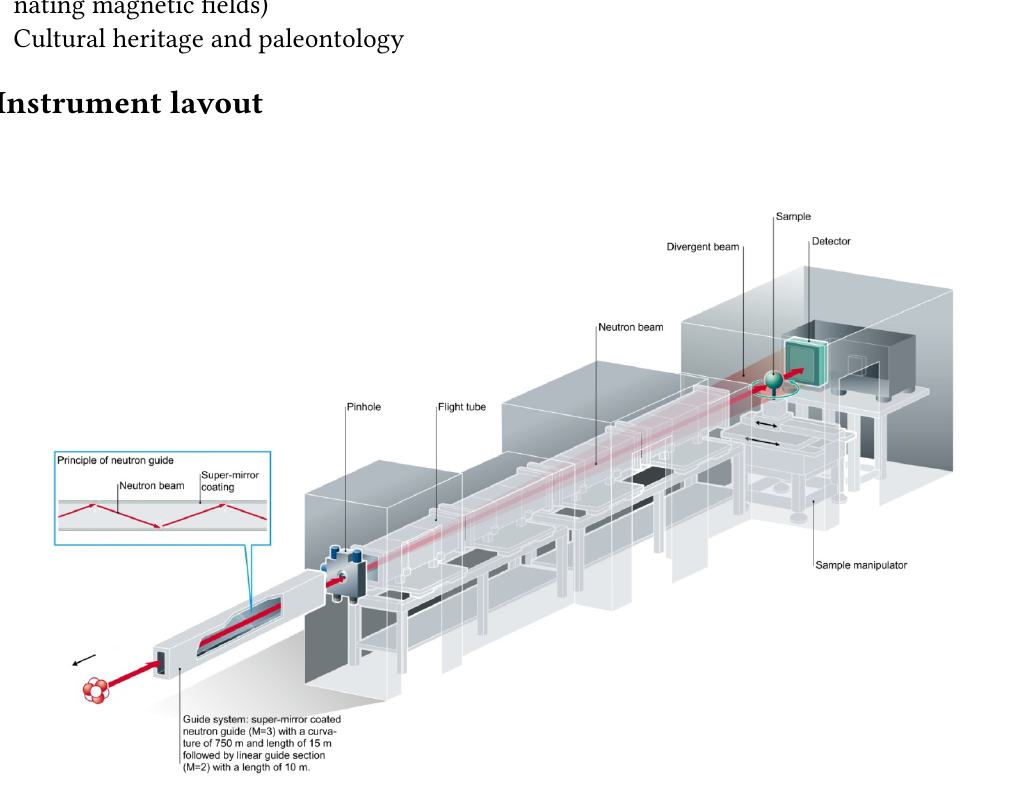
Figure 2: Schematic view of